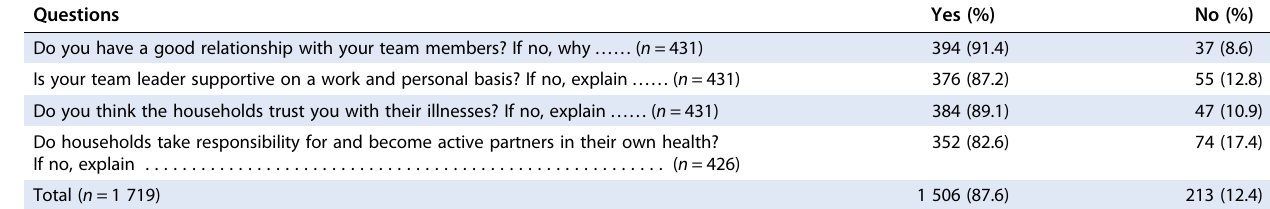
Table 3: Teamwork among members Questions